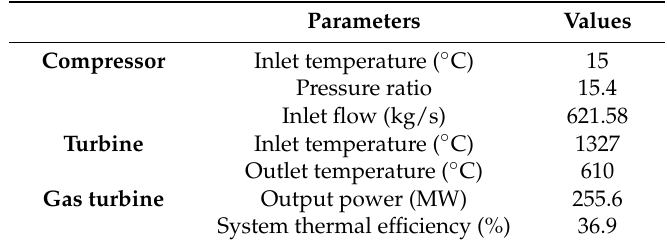
Table 2. The design data of PG9351FA gas turbine.